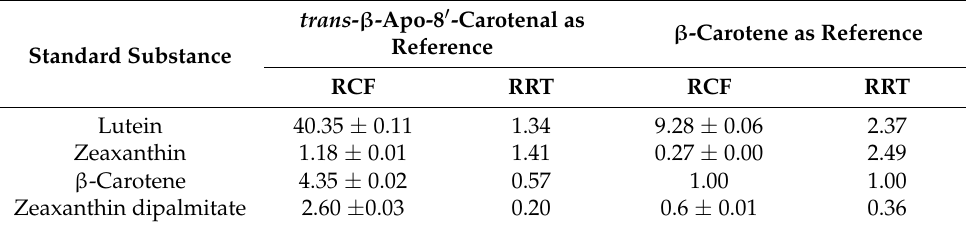
Table 2. RCF values calculated by using trans - β -Apo-8 (cid:48) -carotenal and β -carotenal as